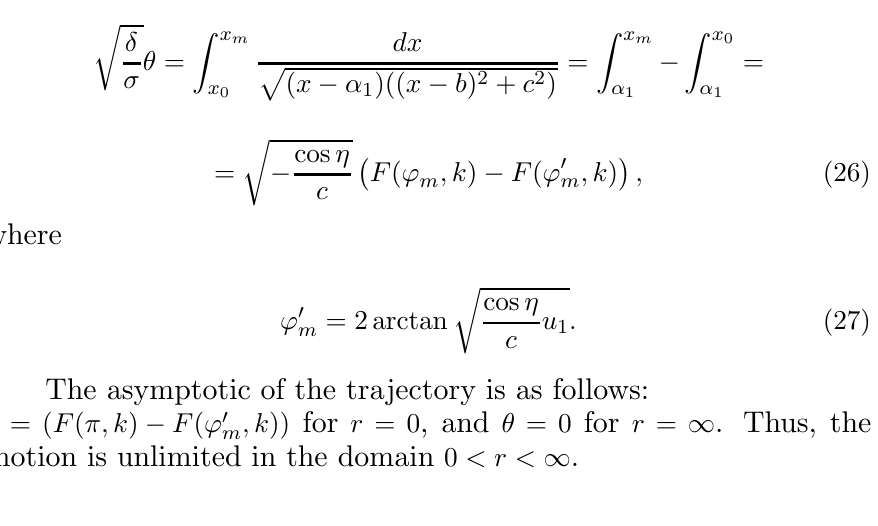
Fig. 6. The graph of limitatory trajectories of the case A4 for (a) u 4 > , u > 0 , δ = 1 , γ = 1 , σ = 1 . 1 + u > u 2 4 > u > u , u ≤ 0 , δ = 1 , γ = 1 , σ = u 4 2 4